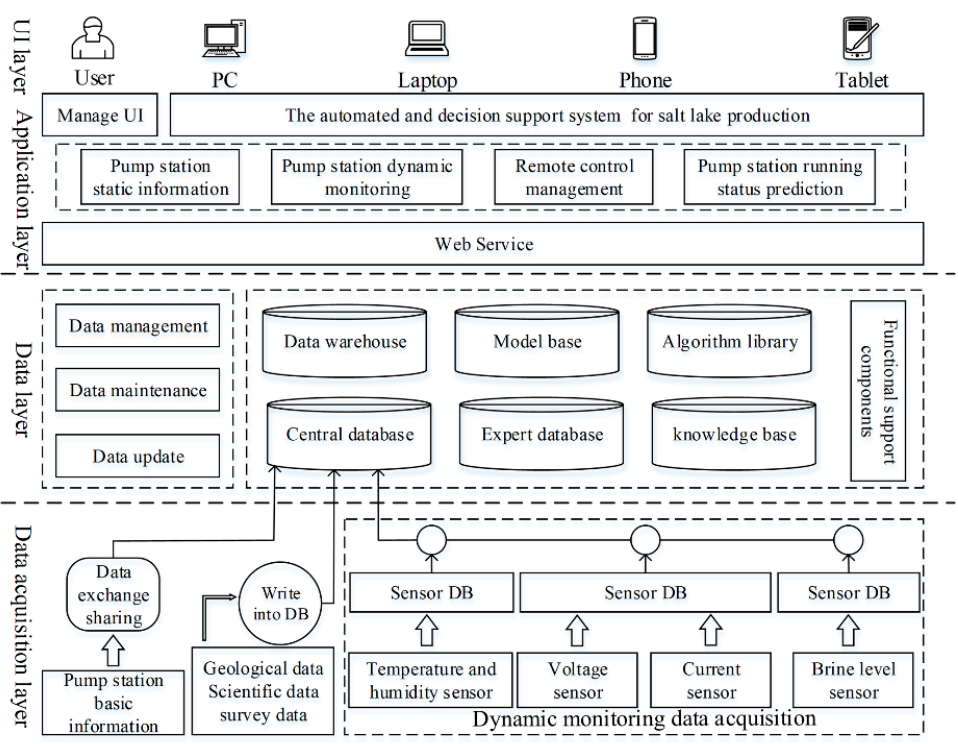
Figure 2. System architecture of decision support system.